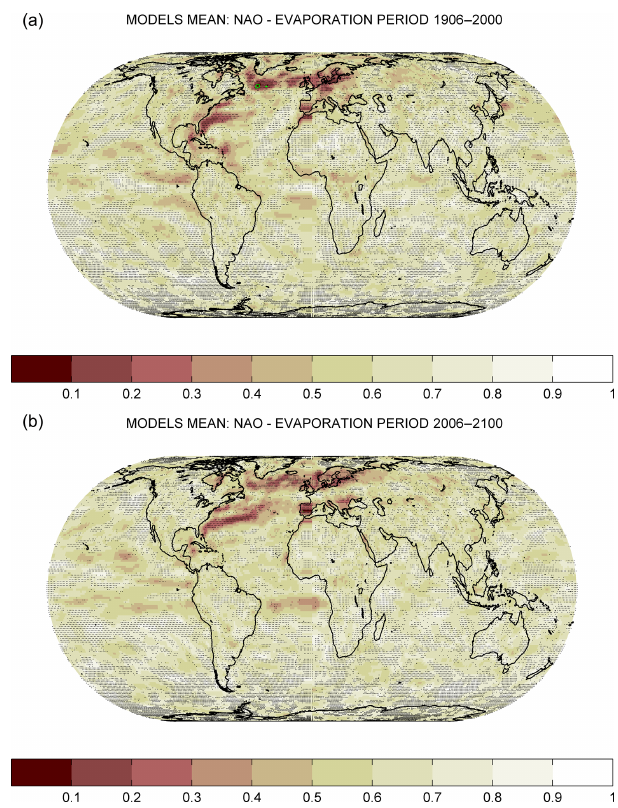
Figure 3. As in Fig. 1 but for Granger causality between NAO and annual mean evaporation. NAO: North Atlantic